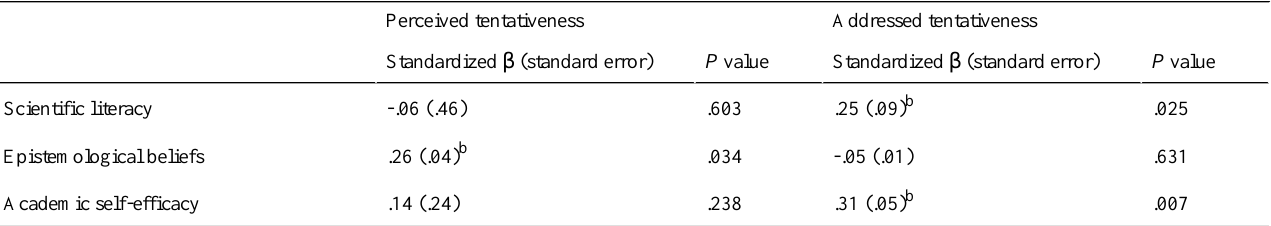
Table 5. Models of perceived tentativeness and addressed tentativeness on scientific literacy, epistemological beliefs, and academic self-efficacy a .